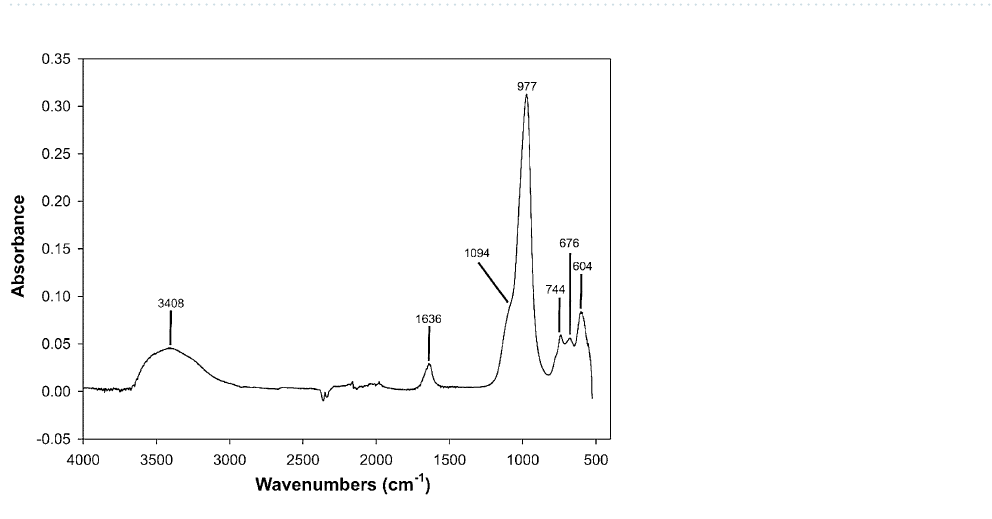
Figure 5. IR spectrum of the Na-P 1 zeolite at 91 h (100